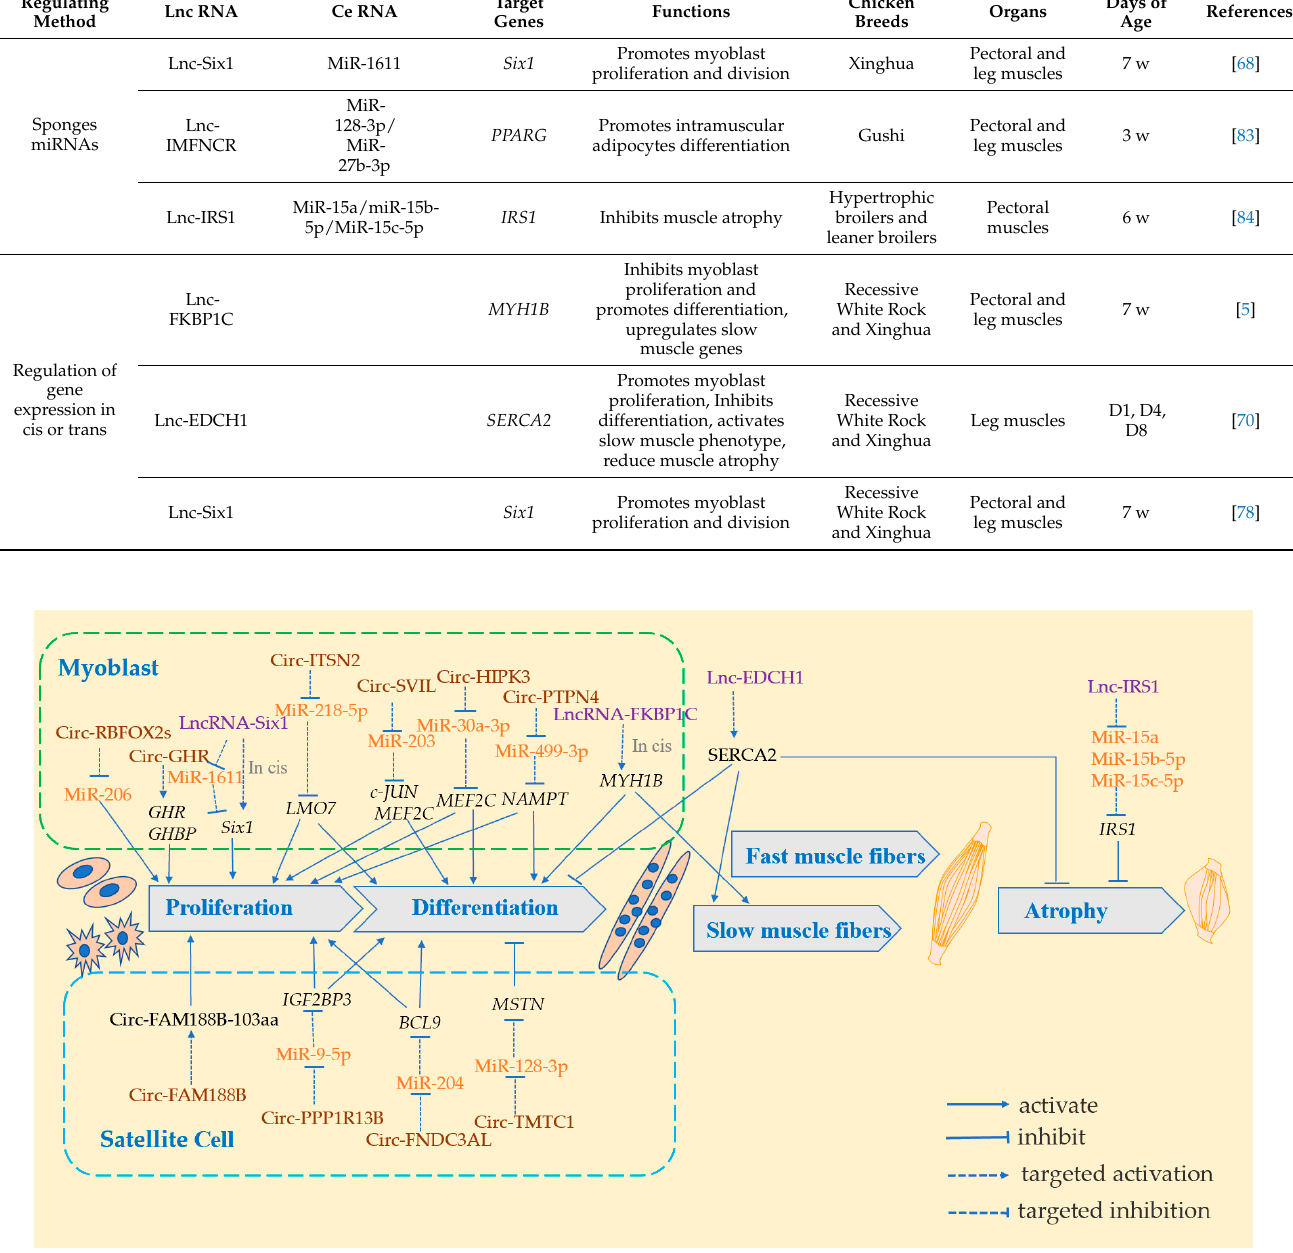
Figure 2. The role of LncRNA and CircRNA in the growth and development of skeletal muscle in domestic chickens. LncRNAs are shown in purple and they promote or suppress various stages of skeletal muscle development (including myoblast proliferation, differentiation, slow muscle fiber formation, and muscle atrophy) by sponging miRNA (miRNA shown in orange) or by cis-regulating the expression of genes (genes in black italics) to promote or inhibit all stages of skeletal muscle development (including myoblast proliferation, differentiation, slow muscle fiber formation, and muscle atrophy) in domestic chicken by alleviating the repression of target genes. CircRNA is shown in brown in the figure and functions to promote or inhibit the proliferation and differentiation of myoblasts and satellite cells. Their functions are through the following three ways: direct regulation of parental genes; sponging miRNA (miRNA shown in orange) to alleviate its repression of target genes; direct translation of CircRNA itself into proteins. (genes shown in black italic, proteins shown in black